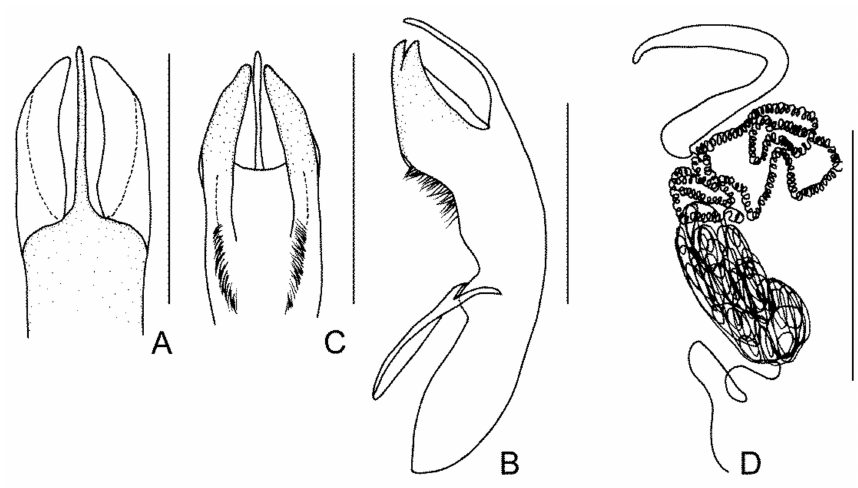
Figure 27. Cryptocephalus ( Burlinius ) petulans Weise, 1889: ( A ) part aedeagus of dorsal view; ( B ) part aedeagus of ventral view; ( C ) lateral view of aedeagus; ( D ) spermatheca (Scale bars: 0.5